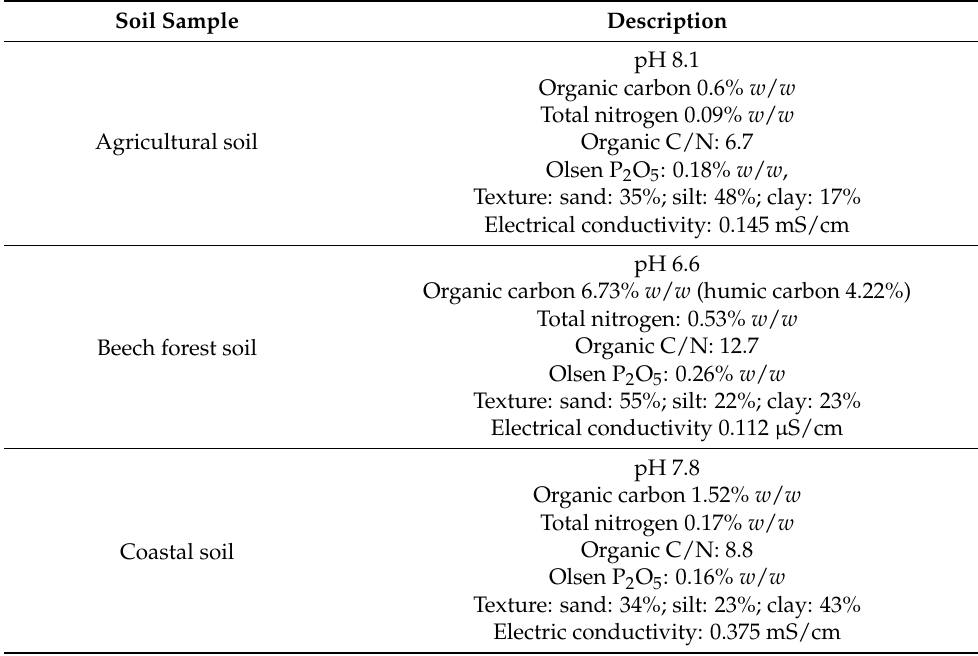
Table 1. Soil samples tested: chemical composition and